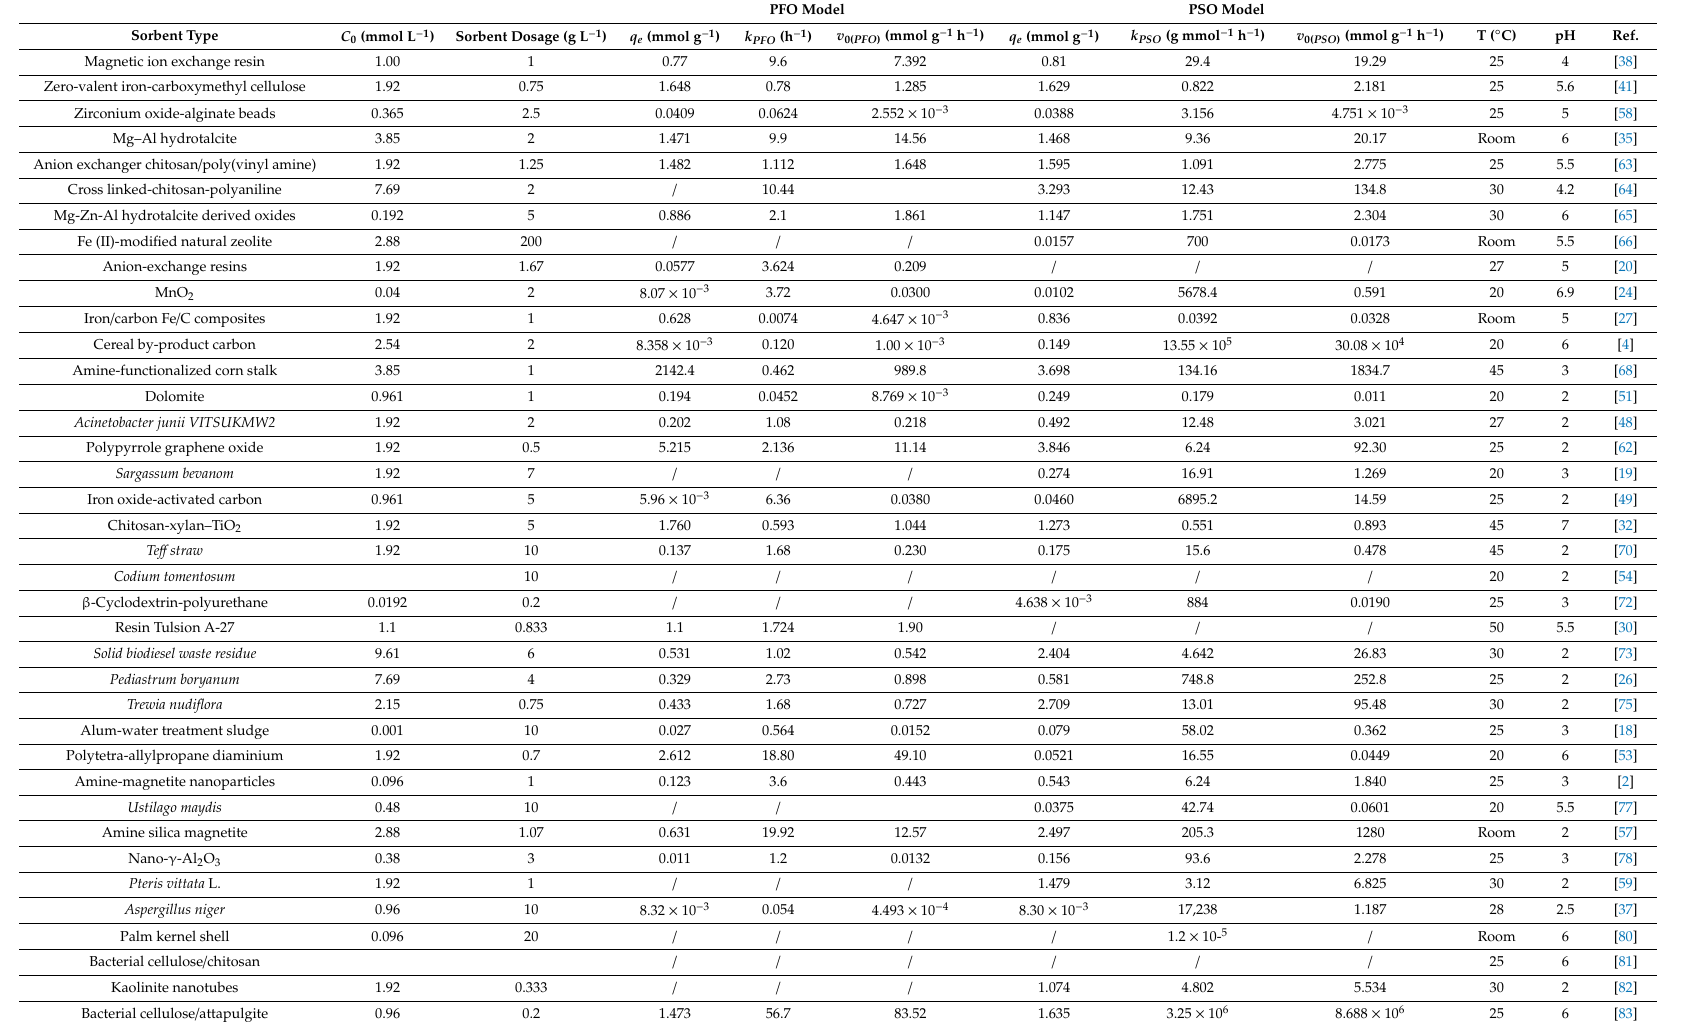
Table 2. Kinetic data for Cr(VI)